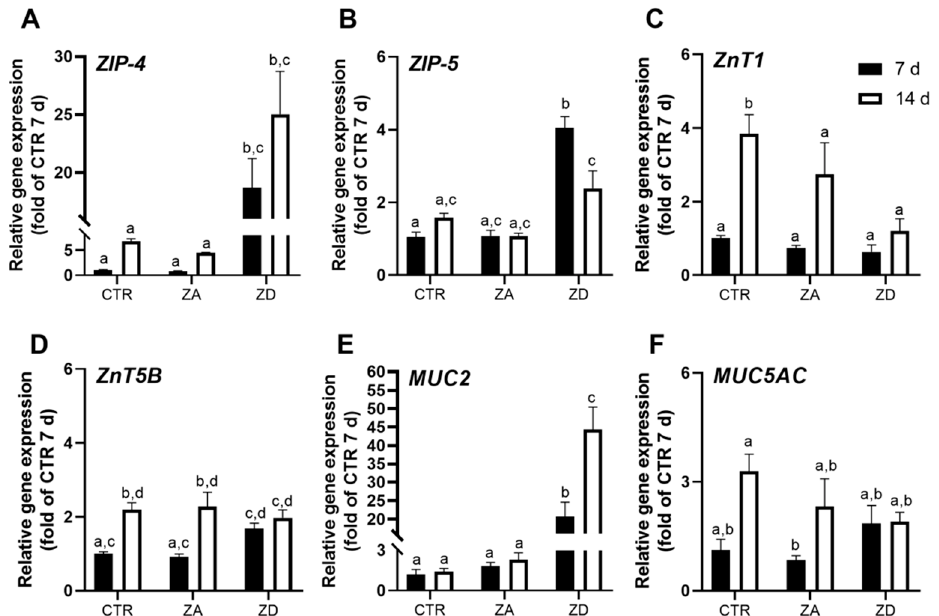
Figure 4. Influence of zinc deficiency on the expression of intestinal zinc transporters ( A – D ) and mucins ( E , F ). HT-29-MTX were cultured for 7 and 14 days in CTR, zinc-adequate (ZA) or -deficient (ZD) medium, respectively, and gene expression analyzed by quantitative real-time PCR (qPCR). Data are presented as means + standard error of mean (SEM) of three independent experiments. Bars sharing letters are not significantly different (Two-Way ANOVA with Bonferroni post-hoc test). Zinc deprivation of goblet cells severely a ff ected the expression of zinc transporters, significantly increasing ZIP-4 mRNA in both confluent and post-confluent cells, leading to 18-fold (Figure 4A; 7 days: p < 0.001 ZD vs. CTR and p < 0.001 ZD vs. ZA) and 25-fold higher (Figure 4A; 14